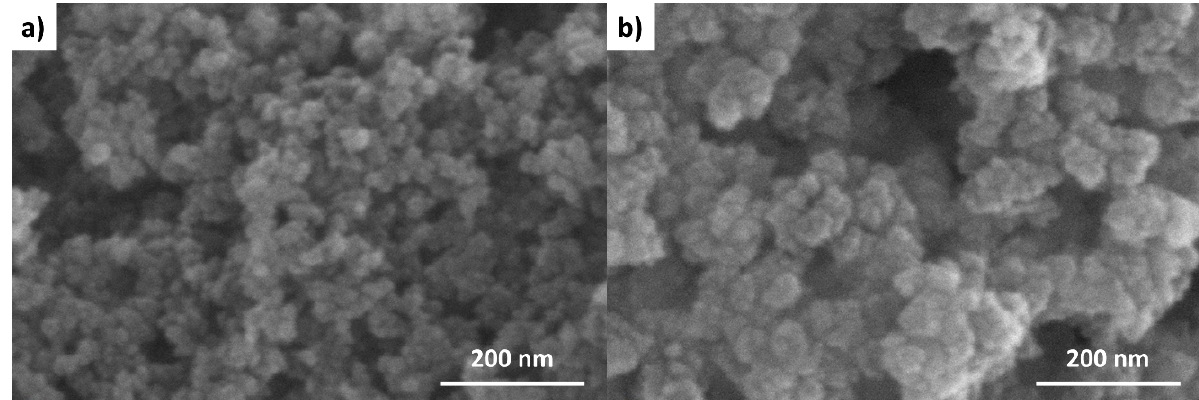
Figure 7. SEM images of ( a ) Re@POP1 and ( b ) Re@POP2 , differently obtained POP.